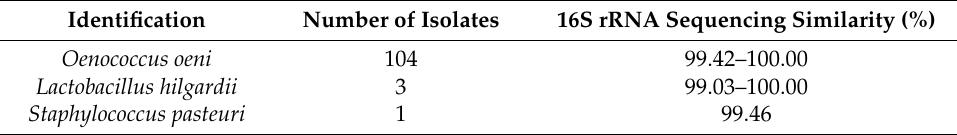
Table 2. Identification of 108 isolates by 16S rRNA